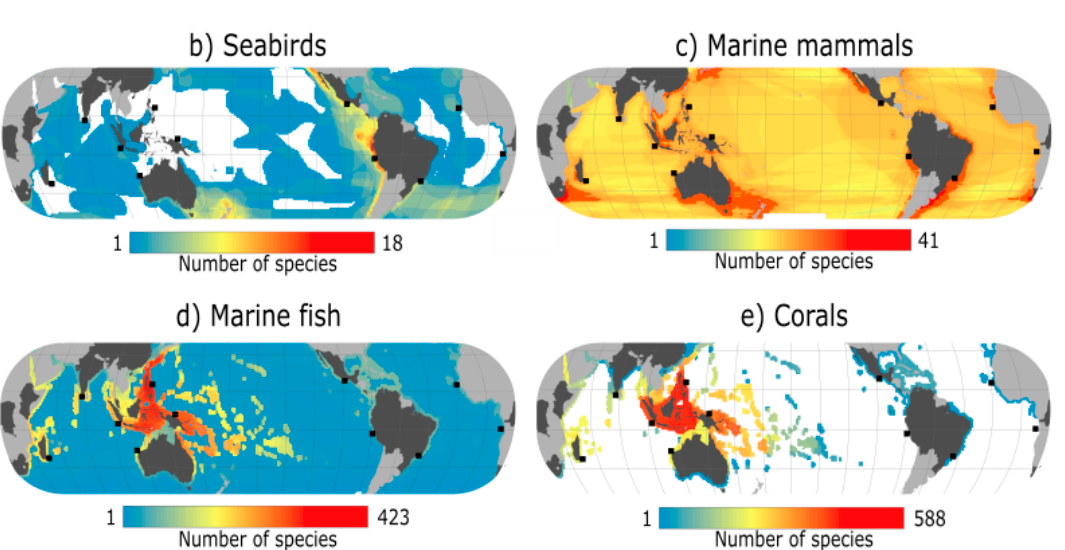
Figure 5. Marine diversity in the Tropics. ( a ) All species, ( b ) seabirds; ( c ) marine mammals; ( d ) marine fish; ( e ) corals. Black squares: Potential sites for wave energy conversion plants, see Figure 2.